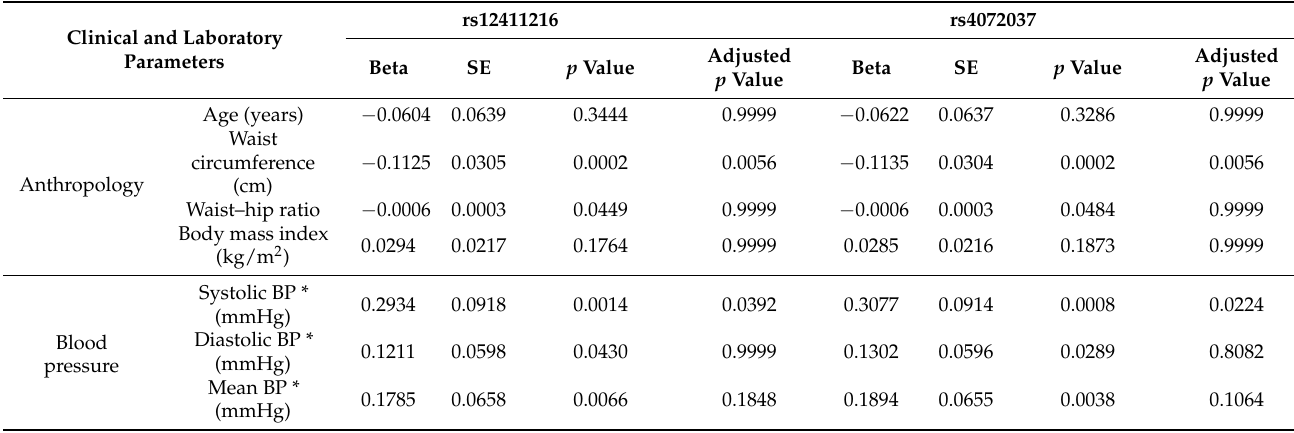
Table 2. Association between MUC1 rs12411216 and rs4072037 genotypes and clinical and laboratory parameters in Taiwan Biobank